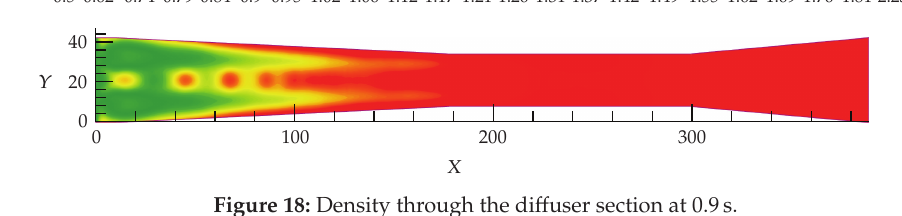
Figure 18: Density through the di ff user section at 0.9s.